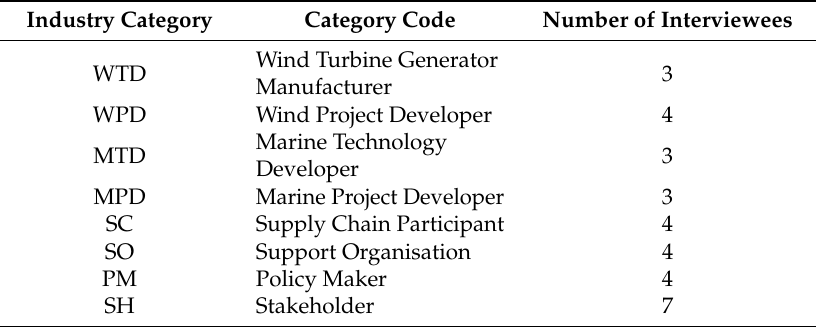
Table 1. Interviewee industry